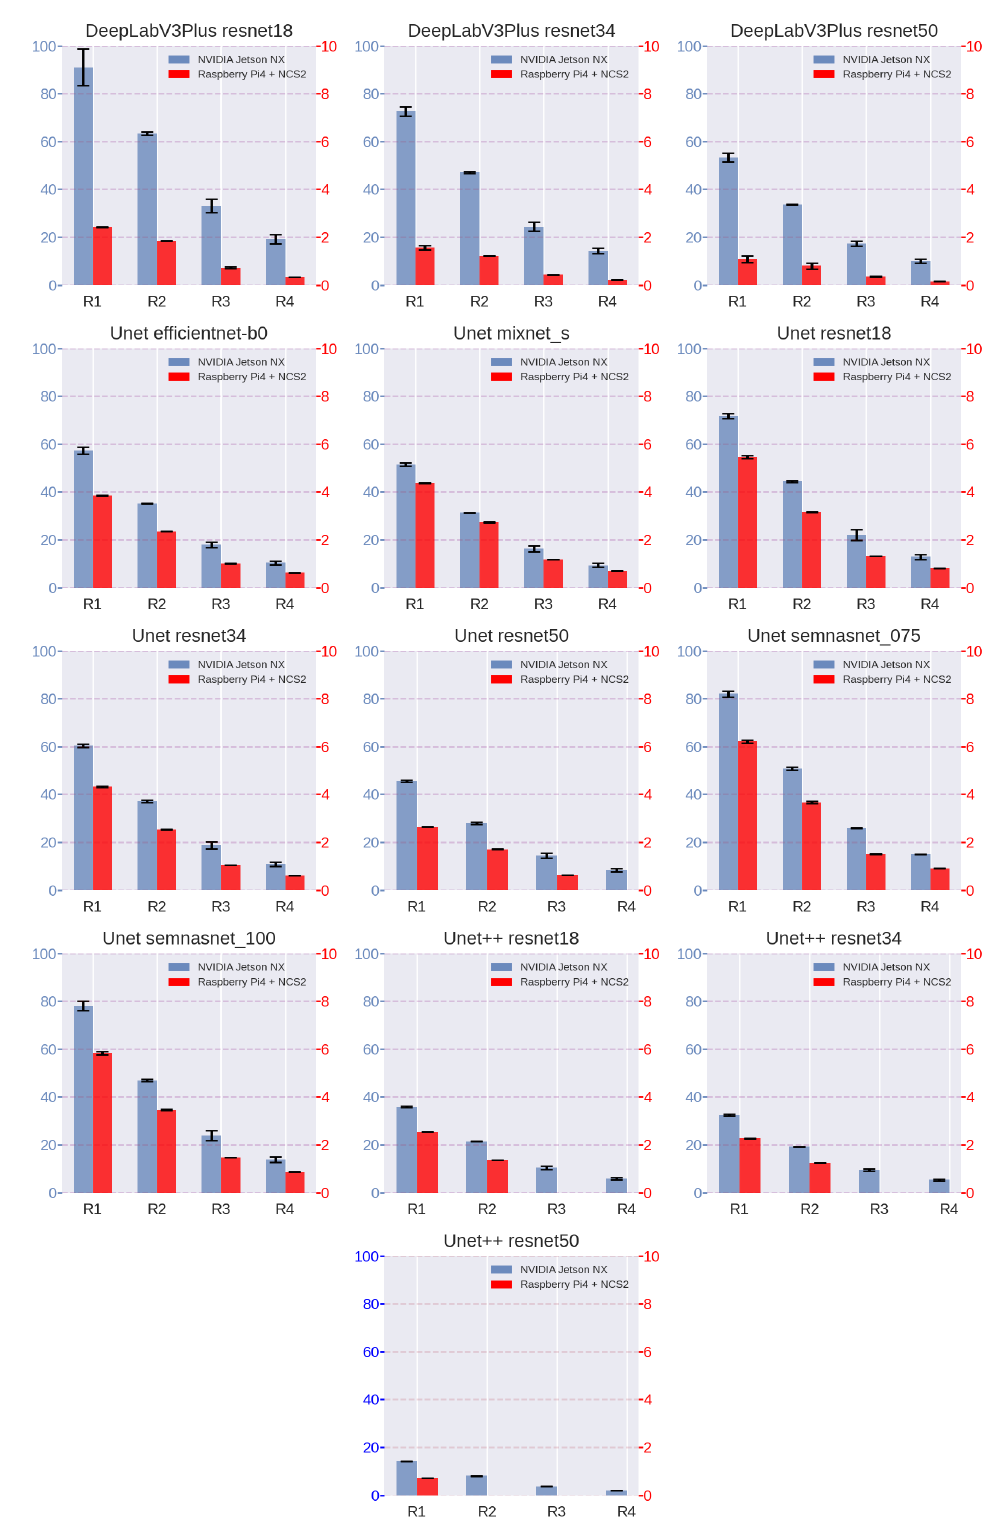
Figure 6. The model performance visualisation (given in frames per second) for various resolutions and both devices NVIDIA Jetson NX (left scale, blue) and Raspberry Pi4 + NCS2 (right scale, red). R1–R4 represent the following input sizes: 480 × 288, 640 × 384, 960 × 540, and 1280 ×